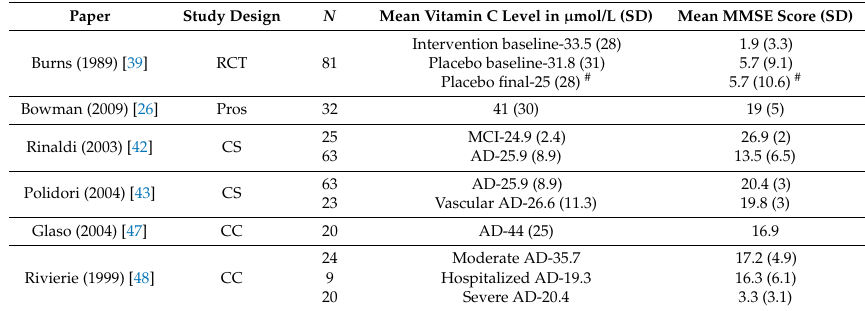
Table 4. Cognitively impaired participants (Mean blood vitamin C/MMSE scores).